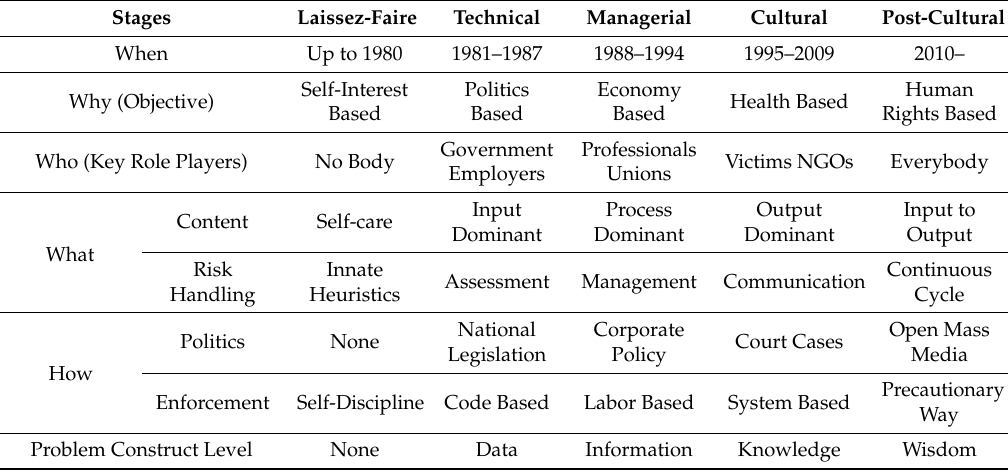
Table 1. Stages of health and safety changes based on narrative